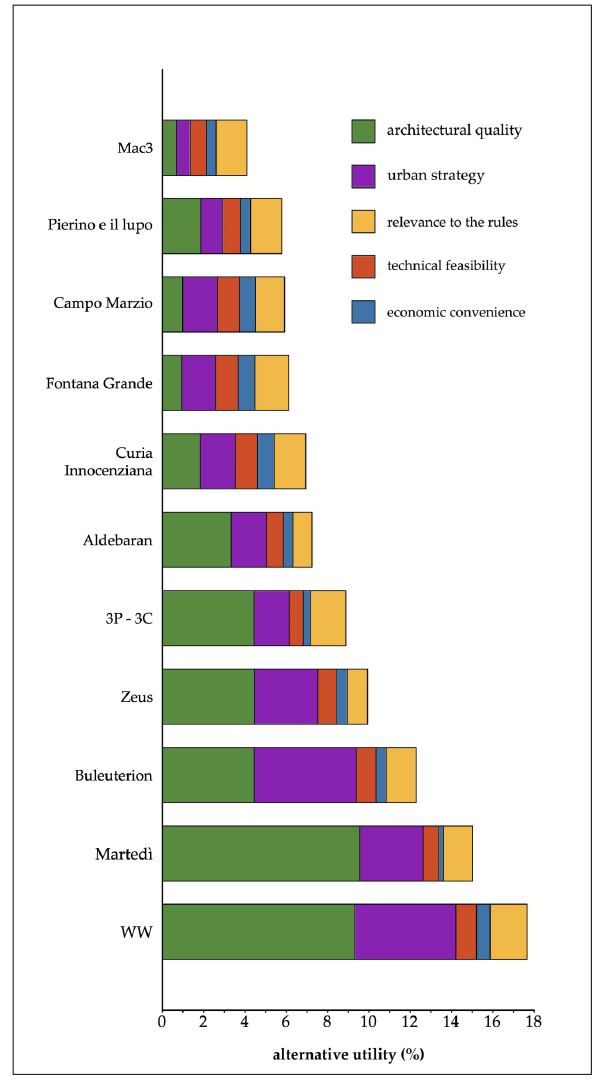
Figure 4. Final results 416